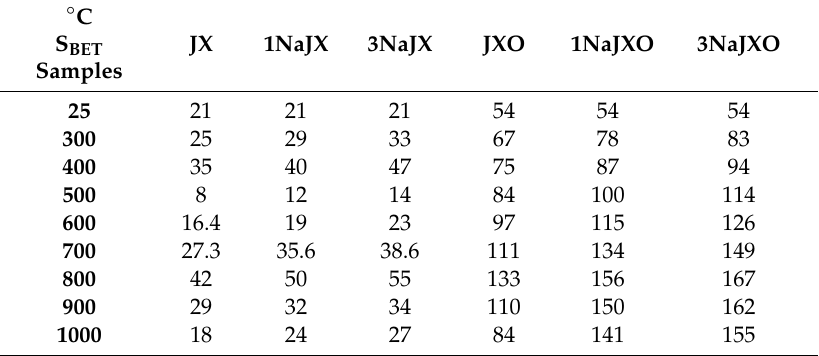
Table 2. The value of S BET (m 2 / g) of chars at